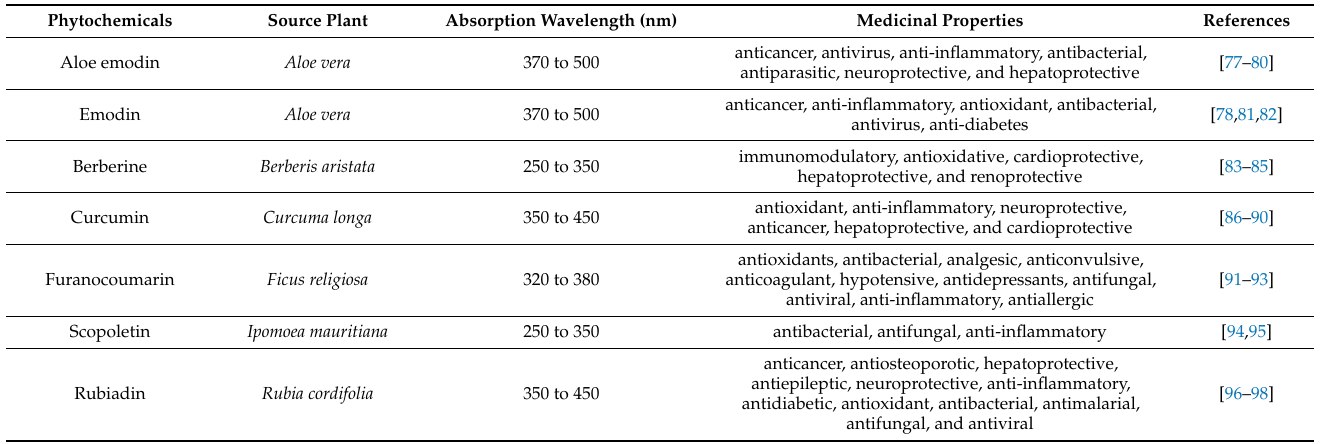
Table 1. Phytochemicals from selected medicinal plants with photosensitizing